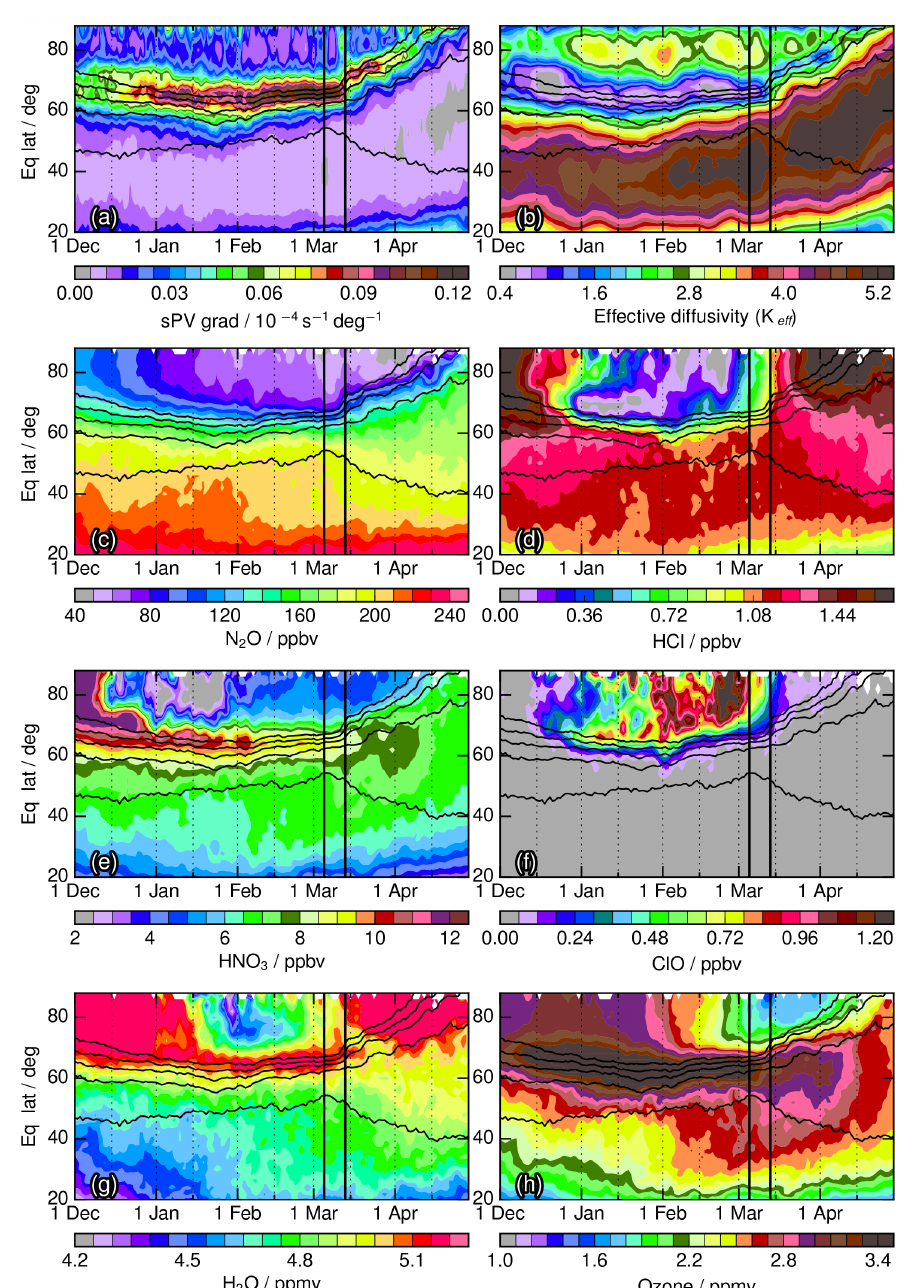
Figure 6. Equivalent latitude–time series at 490K for 2015/16; as in Fig. 5 but showing (a) sPV gradients, (b) K eff , (c) N 2 O, (d) HCl, (e) HNO 3 , (f) ClO, (g) H 2 O, and (h)